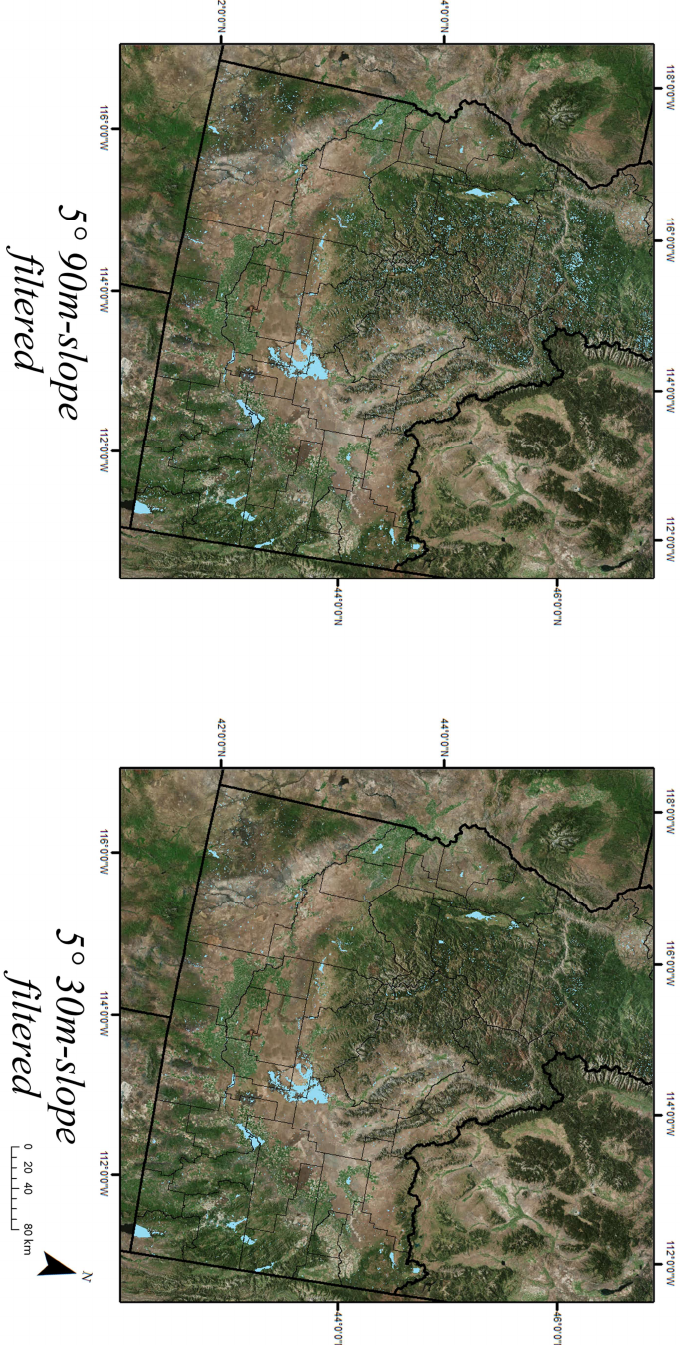
Figure 8. Water surface and filtered results from 5° slope data at 90 m and 30 m digital elevation model (DEM).